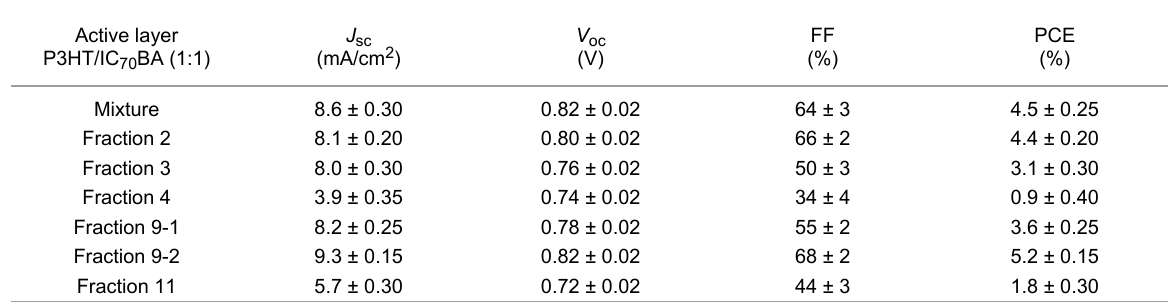
Table 2: Performance of BHJ solar cell devices based on a blend of P3HT and each IC 70 BA fractions as the active layer. a